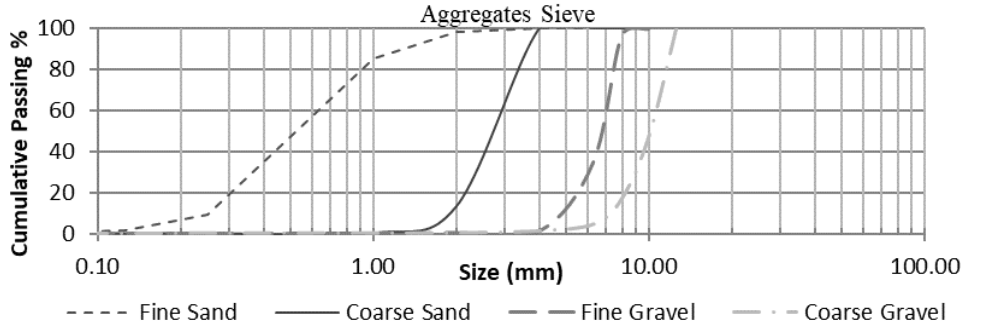
Figure 1. MWCNTs SEM images and their measured diameters.